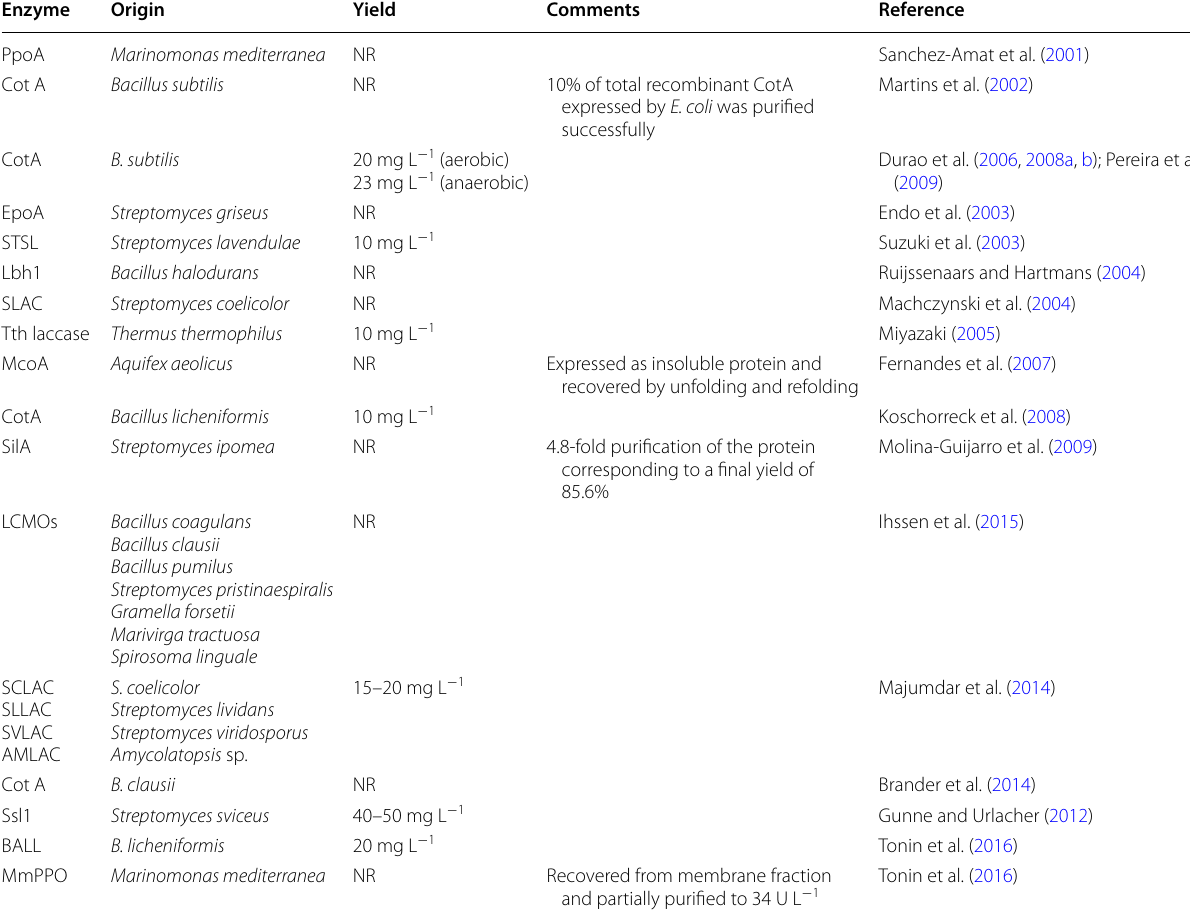
Table 2 Bacterial laccases, laccase-like phenol oxidases and multi-copper oxidases produced by heterologous expression in E.